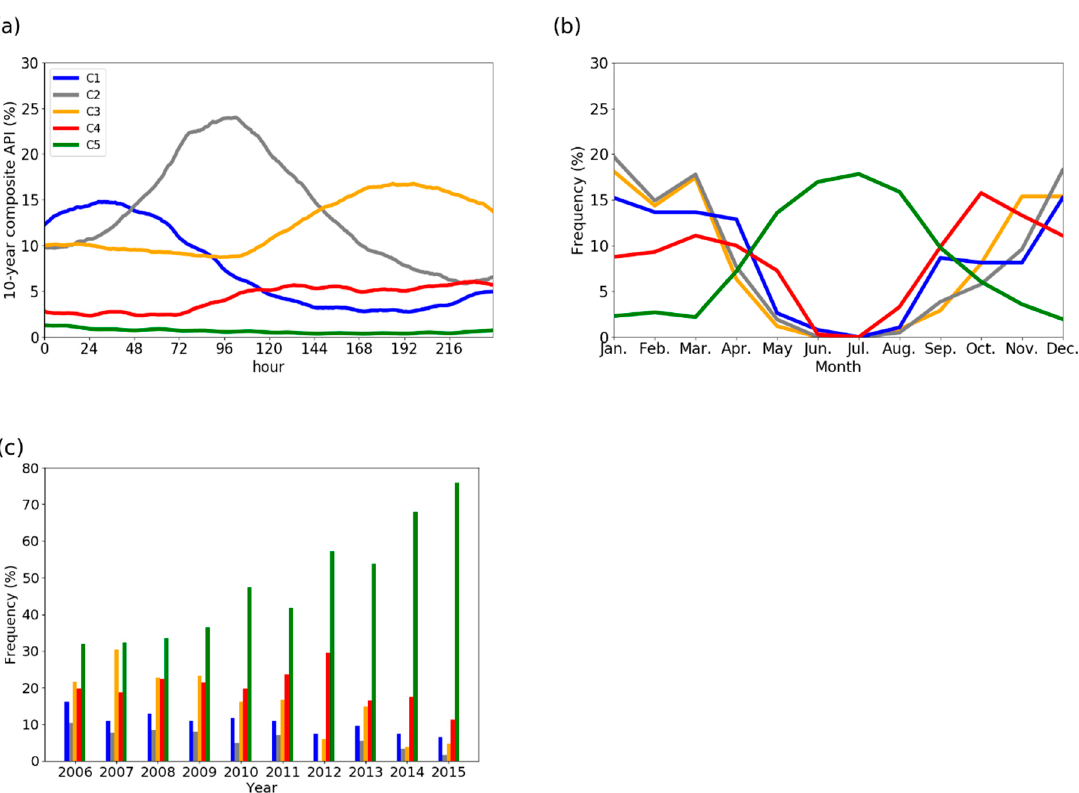
Figure 3. ( a ) Composite API values over 2006 to 2015 of each cluster, ( b ) Monthly frequency of occurrence of each cluster. ( c ) Annual frequency of each cluster over 2006–2015. The blue, gray, orange, red, and green lines represent cluster 1, cluster 2, cluster 3, cluster 4, and cluster 5, respectively.